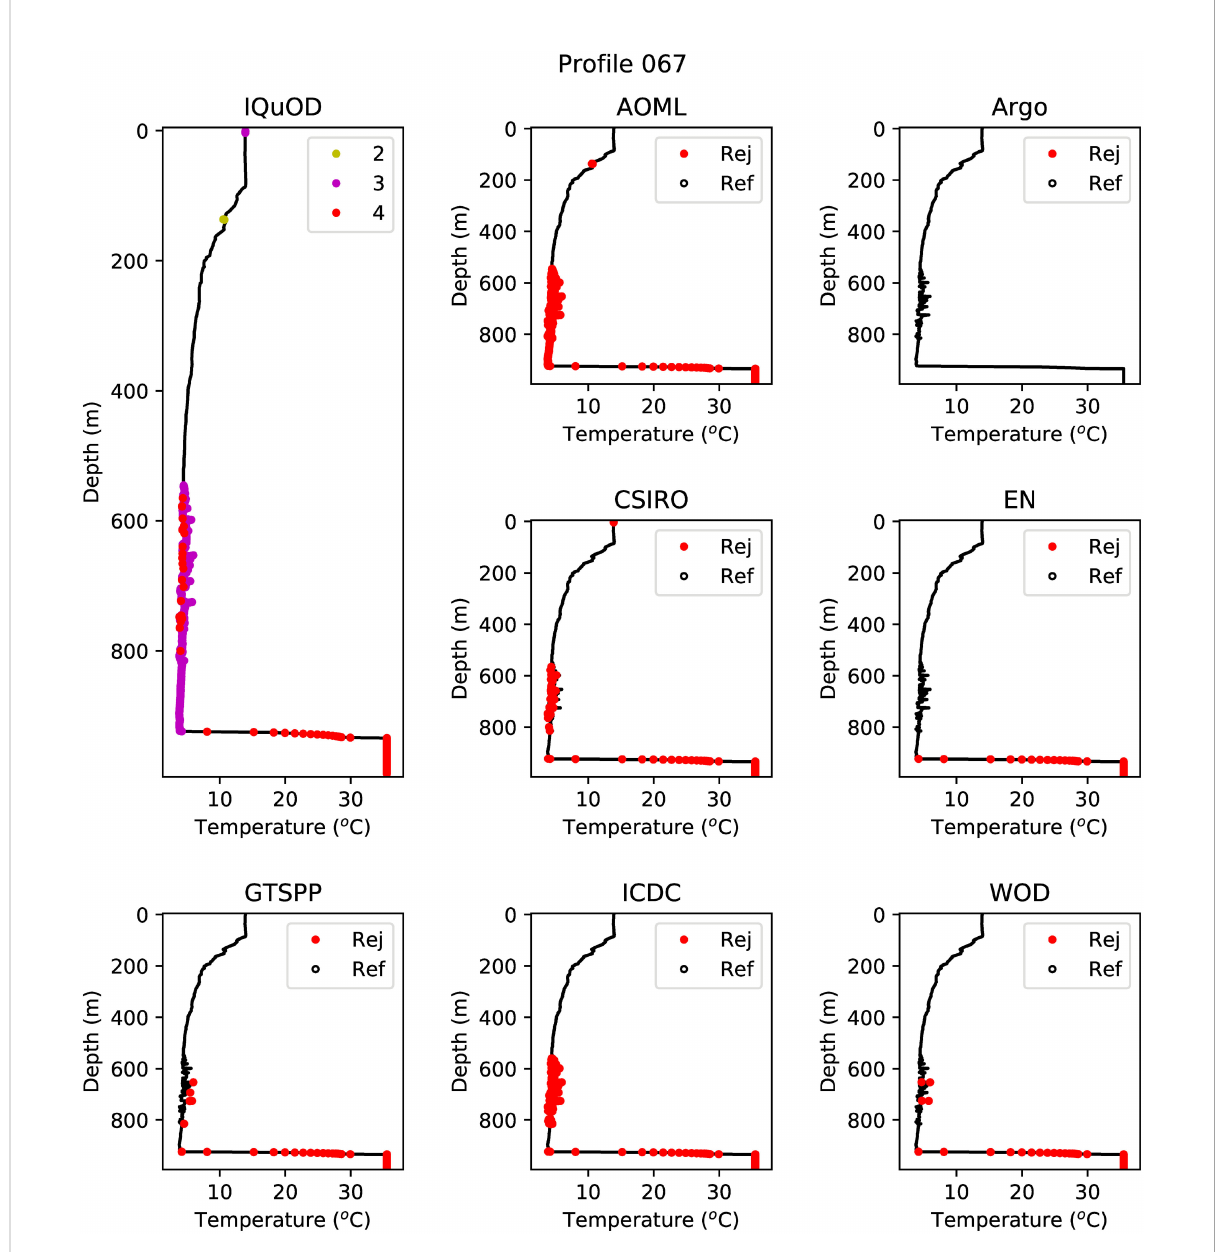
FIGURE 7 As Figure 3 except for an example pro fi le from the NOAA/AOML dataset. This pro fi le is from the South Atlantic Ocean at 43.500°S and 40.886° W and has a time stamp of 1 September 2017. It shows many spikes between 550 m and 850